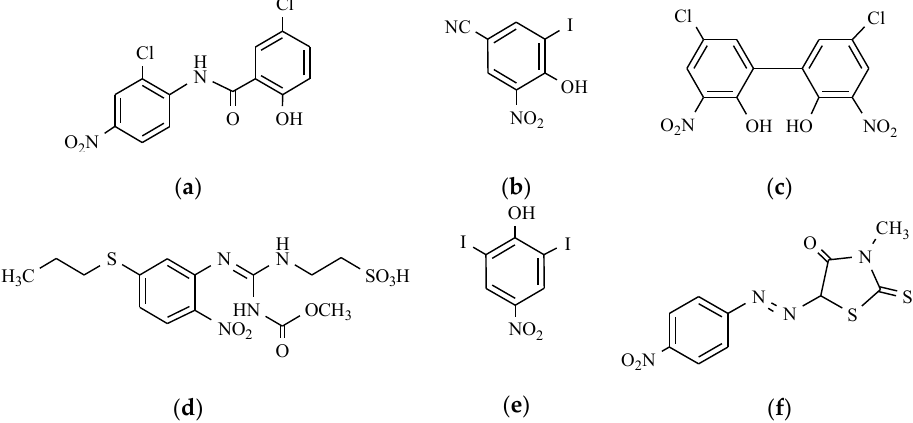
( b ) Figure 13. The chemical structures of 5-nitrothiazole: ( a ) Niridazole, and ( b ) Nitromide. 8. Anthelmintics The parasites that cause infections of the gastrointestinal tract in our latitude come from the two families: roundworms ( Nemathelminthes ) and tapeworms ( Plathelminthes ), which include tapeworms ( Cestoda ) and flukes ( Trematoda ) [30]. Drugs used for the control of parasitic diseases belong to different chemical groups, and their mechanism of action also varies. The drug of choice for the treatment of taeniasis, and which contains the nitro group in their structure, is niclosamide (Figure 14). It is used in the taeniasis of the gastrointestinal system that is caused by Taenia solium , Taenia